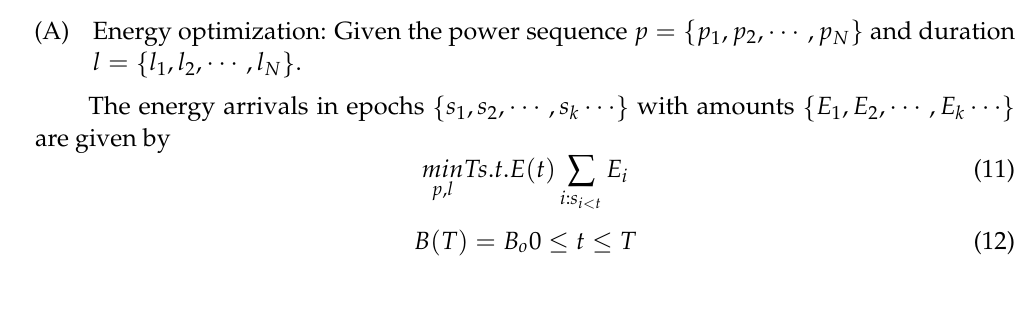
Figure 3. Directional water-filling